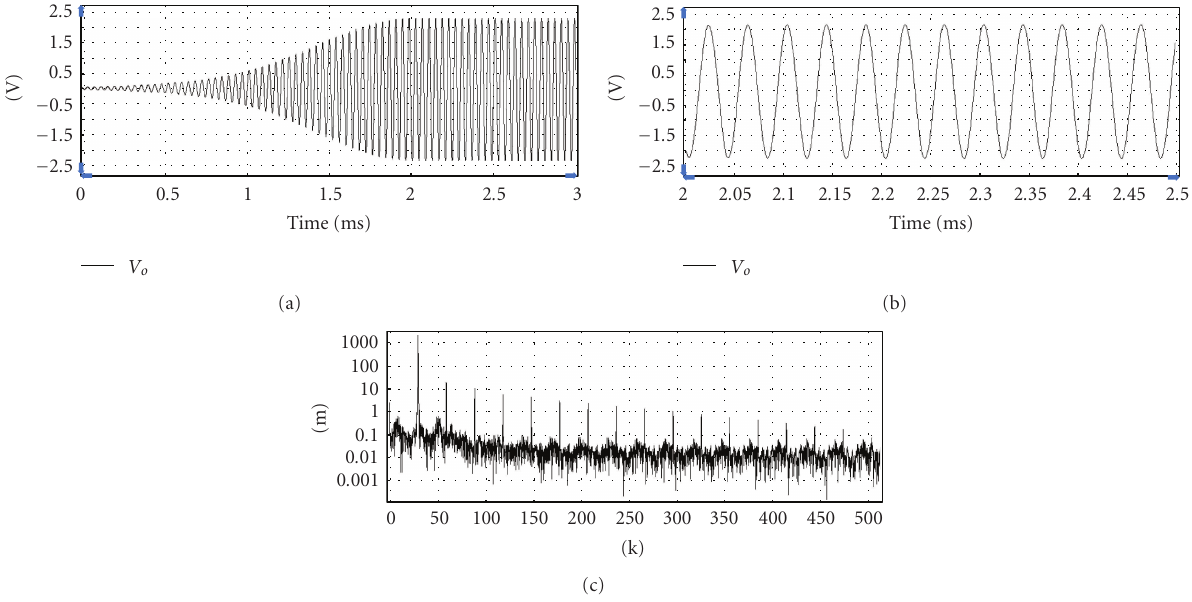
where α 0 and β 0 represent the DC transfer gains.